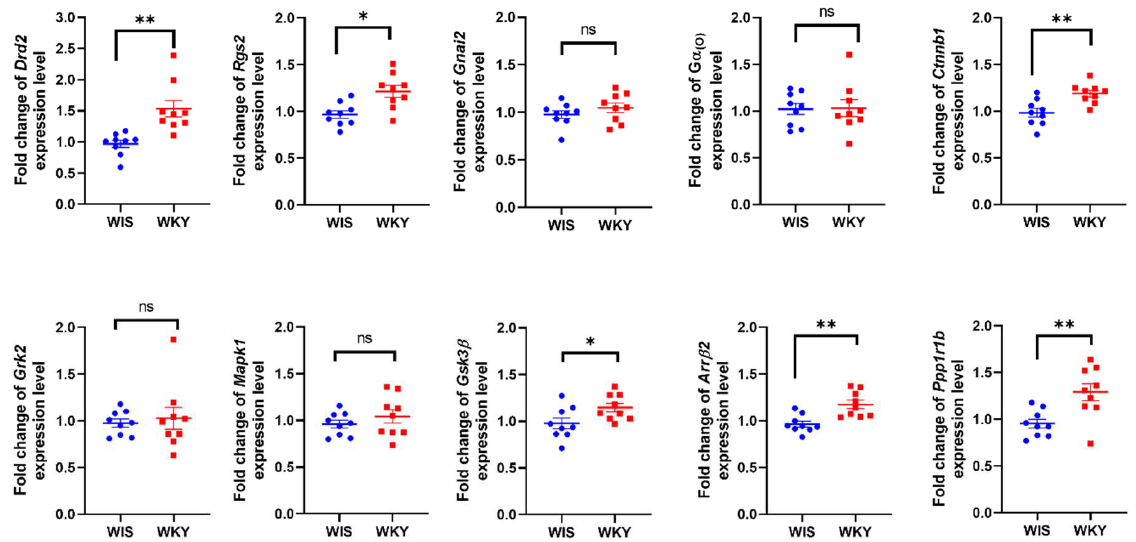
Figure 2. Fold changes in the mRNA expression of the selected genes in the prefrontal cortex (PFc). Individuals are shown in all the figures of n = 9, per group. Statistically significant changes are indicated as * p < 0.05, whereas ** p < 0.01, ns means no statistically significant changes; WKY (red points) vs. WIS (blue points). Abbreviations: Drd2 —dopamine receptor D2; Rgs2 —regulator of G protein signaling 2; Ctnnb1 —catenin beta 1; Arrβ2 —arrestin beta 2; Gsk-3β —glycogen synthase kinase 3 beta; Ppp1r1b —protein phosphatase 1 regulatory inhibitor subunit 1B; Gnai2 —G protein subunit alpha I2; Gnao1 —G protein subunit alpha O1; Mapk1 —mitogen-activated protein kinase 1; and Grk2 —protein-coupled receptor kinase 2.